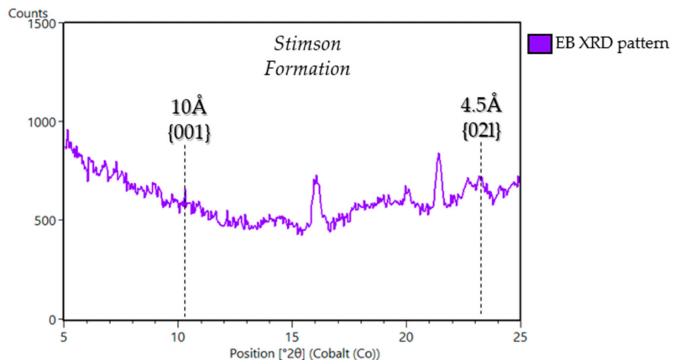
Figure 20. CheMin XRD pattern from 5 ◦ to 25 ◦ 2 θ of sample EB. The basal d-spacing peaks of the 001 of 10 Å and 02l of 4.5 Å are denoted by dashed black lines. A weak, broad 10 Å peak is seen in the EB indicating a poorly crystalline